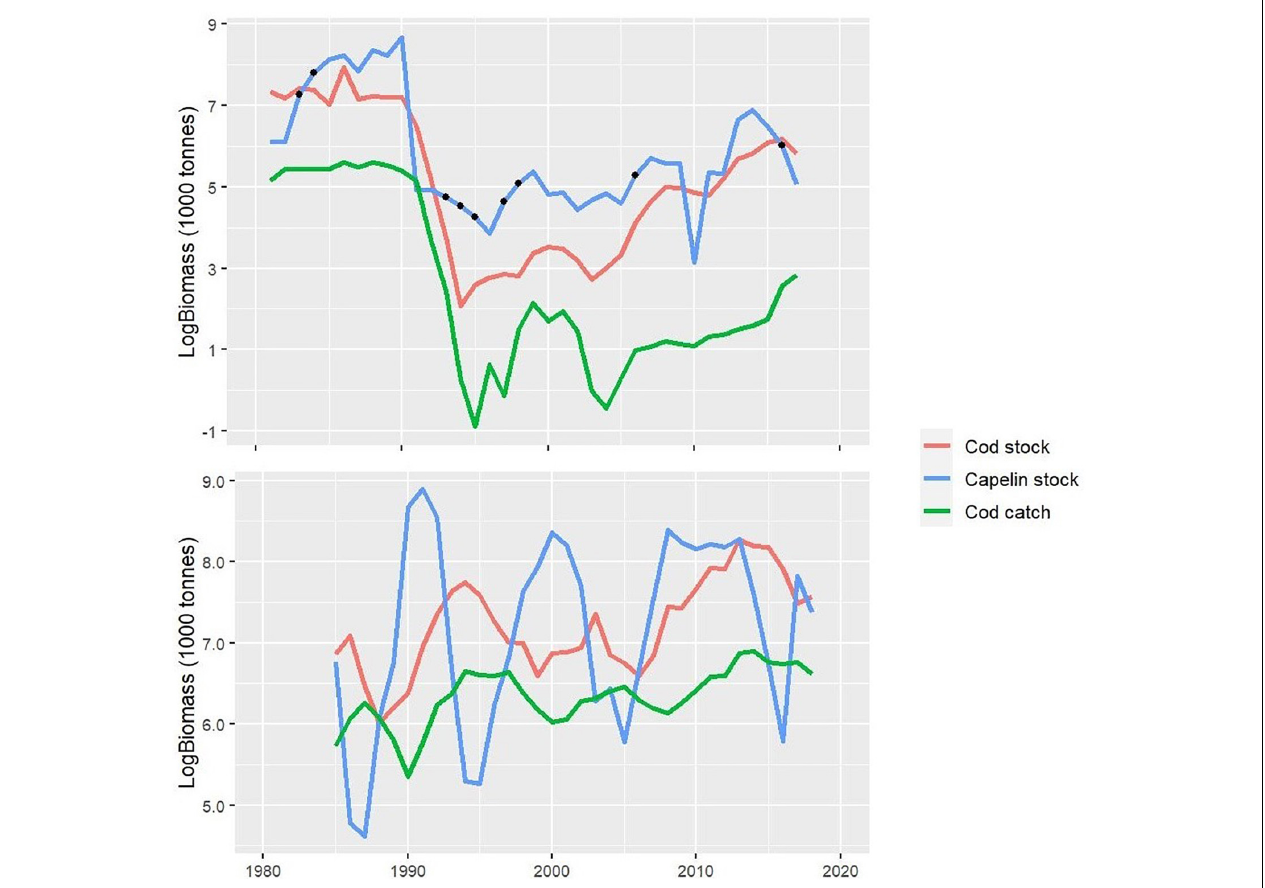
FIGURE 2 | Input time series data (log scale) for cod, capelin, and cod catches used for the Newfoundland-Labrador shelves (NL) (top panel) and Barents Sea (BS) (bottom panel) cod models. The black dots in the capelin time series in NL represent the interpolated years (see text for details).